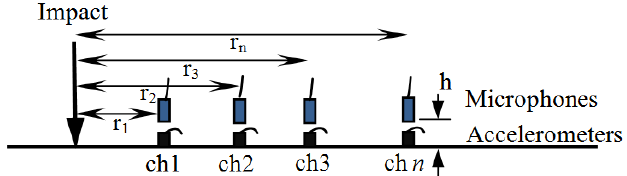
Figure 2. Typical air-coupled SASW/MASW